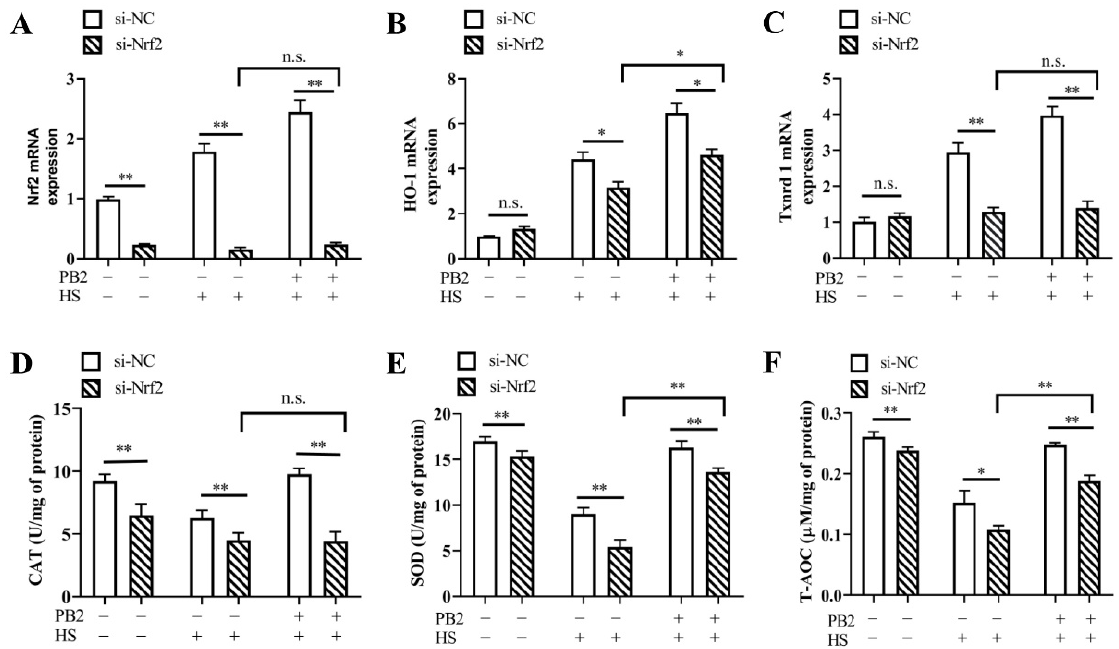
Figure 7. Effect of Nrf2 knockdown on oxidative stress in MAC-T cells. MAC-T cells were transfected with si-Nrf2 or si-NC for 12 h, and then incubated with/without 25 µ M PB2 for 24 h, followed by HS treatment for 3 h and recovery for 6 h. Then, the cells were analyzed for ( A ) Nrf2 mRNA, ( B ) HO-1 mRNA, and ( C ) Txnrd1 mRNA levels. n = 3. Additionally, ( D ) the catalase (CAT) activity, ( E ) the superoxide dismutase (SOD) activity, and ( F ) the total antioxidant capacity (T-AOC) activity were detected. n ≥ 6. * p < 0.05, ** p < 0.01, n.s. p >